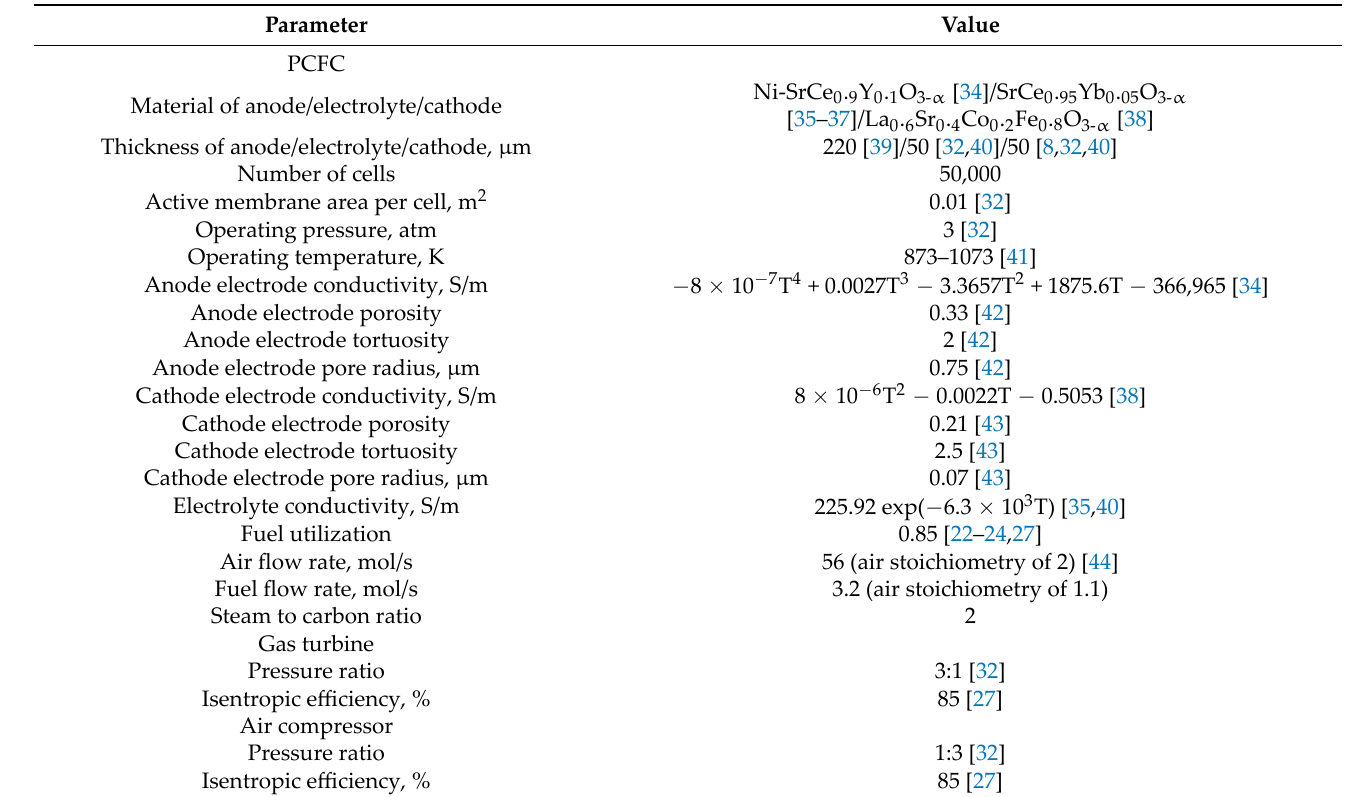
Table 1. Balance of plant of PCFC/GT hybrid